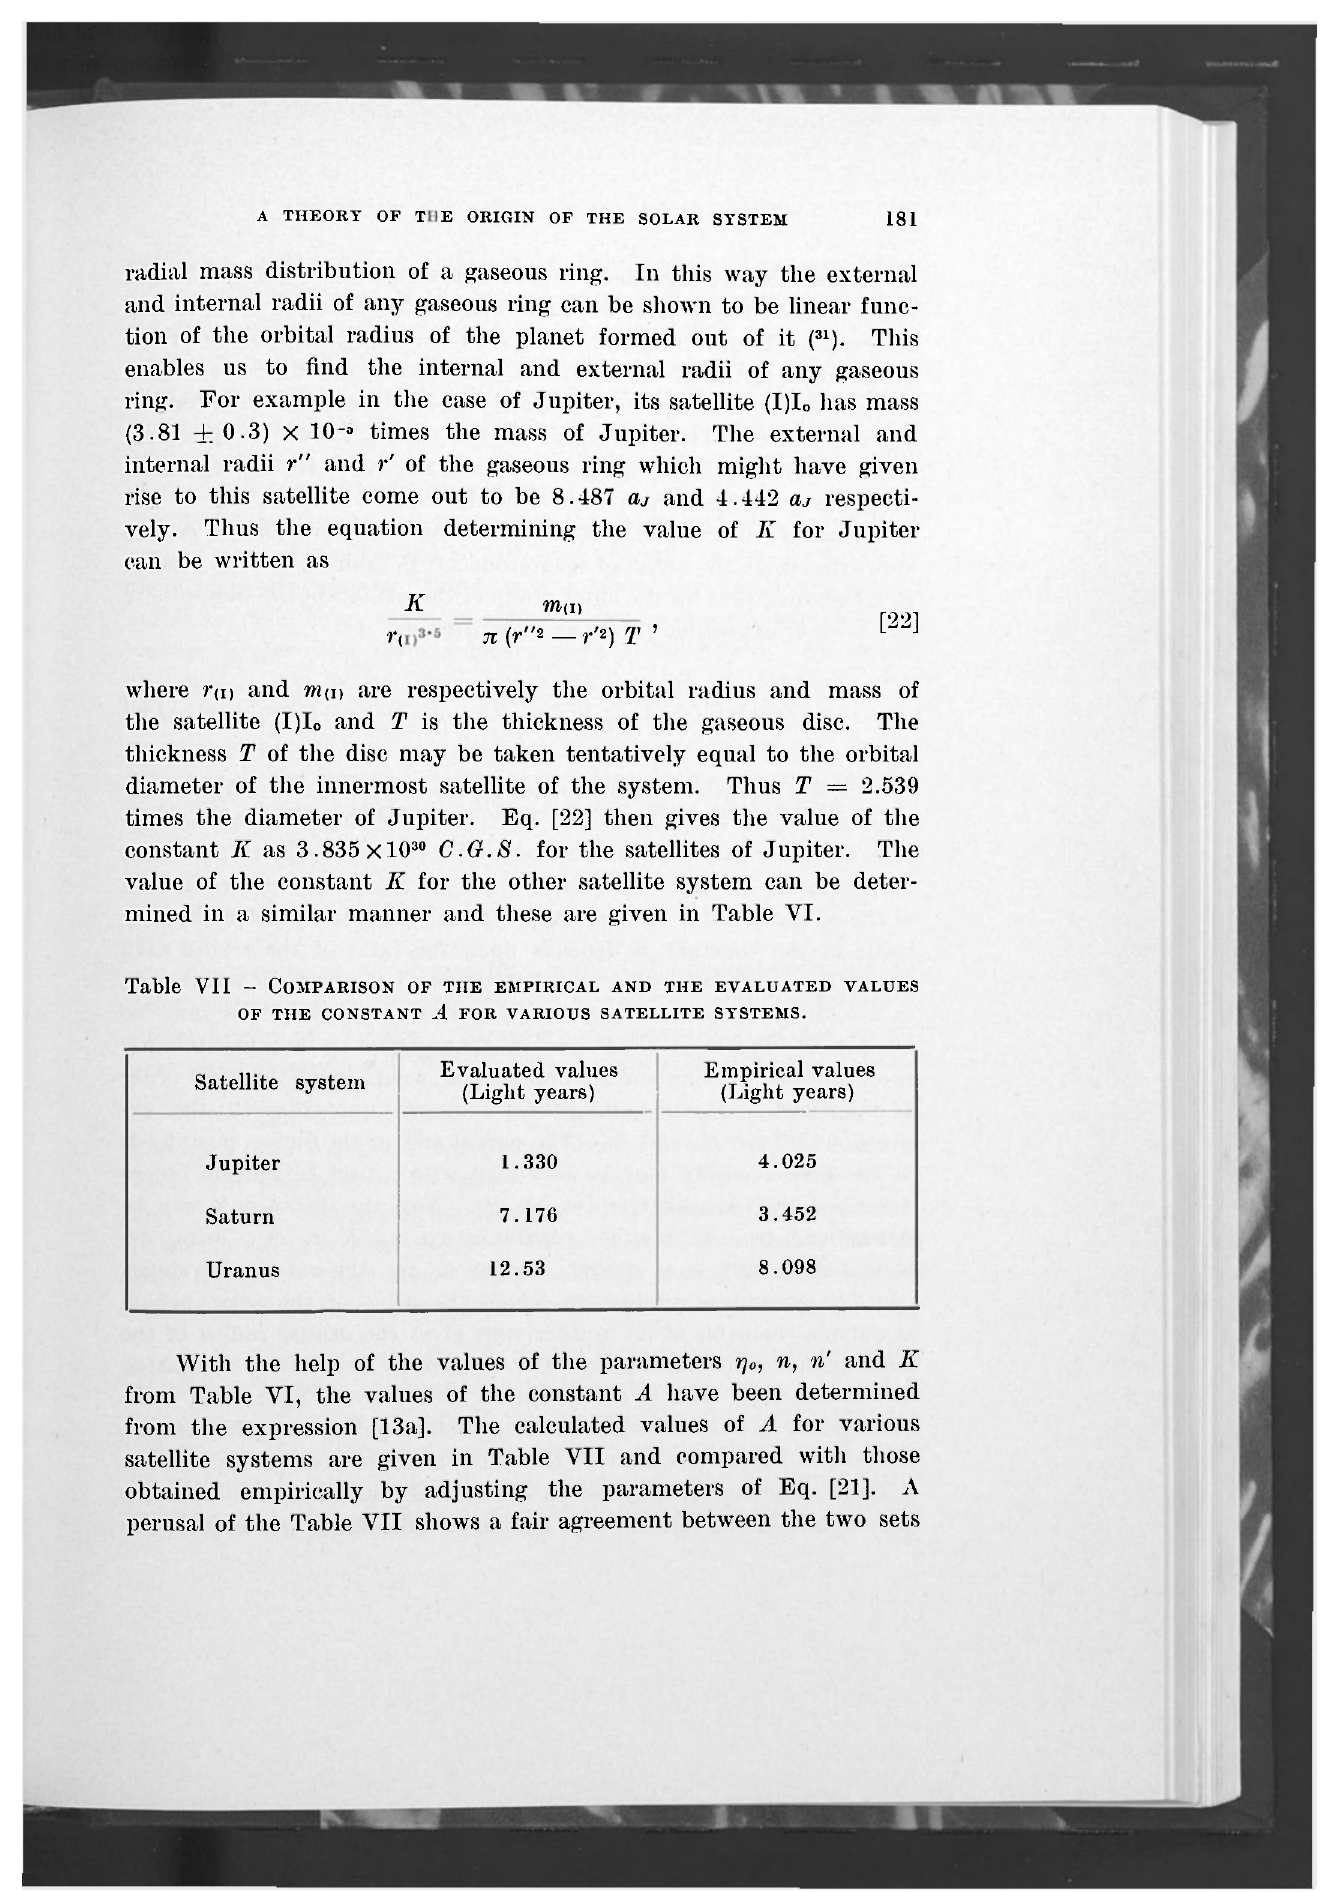
Table V II - COMPARISON OP THE EMPIRICAL AND THE EVALUATED VALUES OF THE CONSTANT A FOR VARIOUS SATELLITE